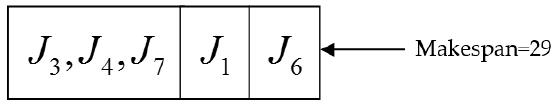
Figure 3. The obtained makespan by Algorithm 2.